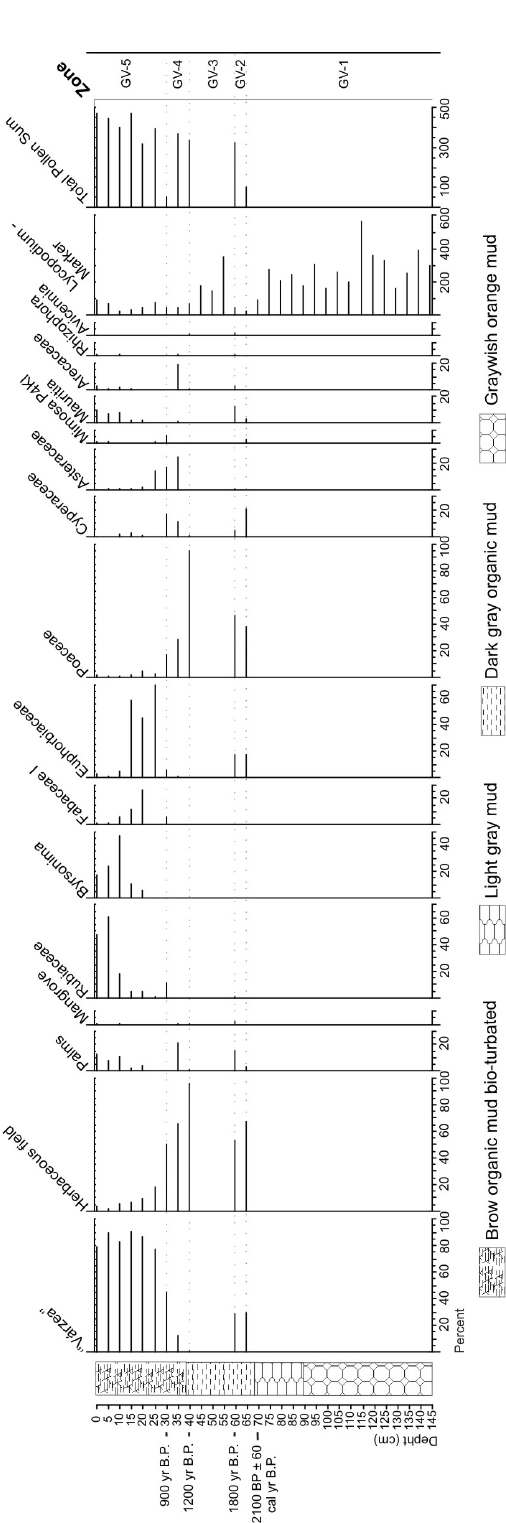
Fig. 2 – Textural description integrated to the pollen profile along the Goiabal Várzea